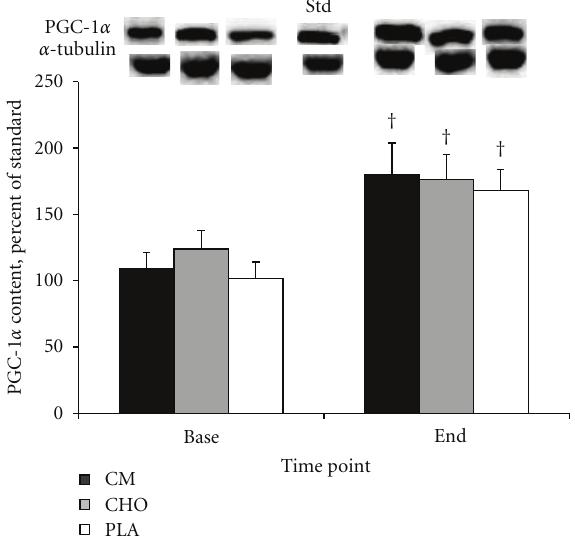
Table 5: Body composition.